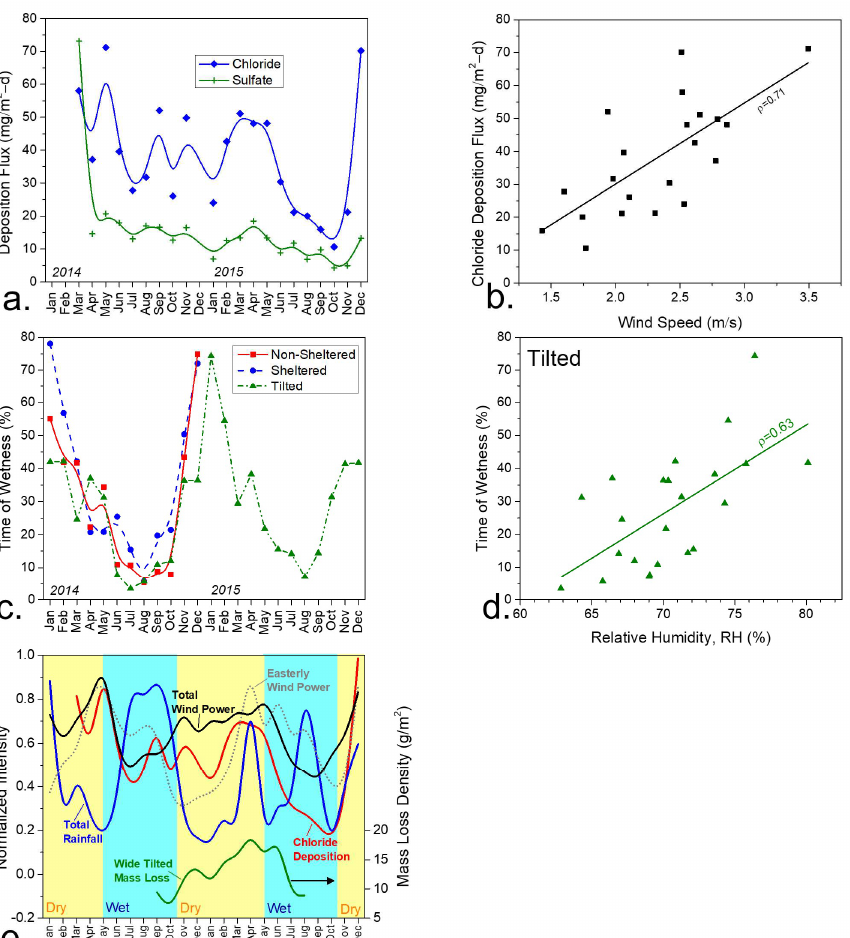
Figure 8. A sample of meteorological data relevant to the assessment of steel corrosion. The deposition flux of chloride and sulfate over the course of the campaign ( a ) and the correlation against wind speed ( b ) are shown. The time of wetness over the campaign ( c ) and the correlation against relative humidity ( d ) are shown. The variation of wind, rainfall, chloride deposition, and steel mass loss is shown seasonally (Winter-Spring-Summer-Fall and also Wet-Dry) ( e ).